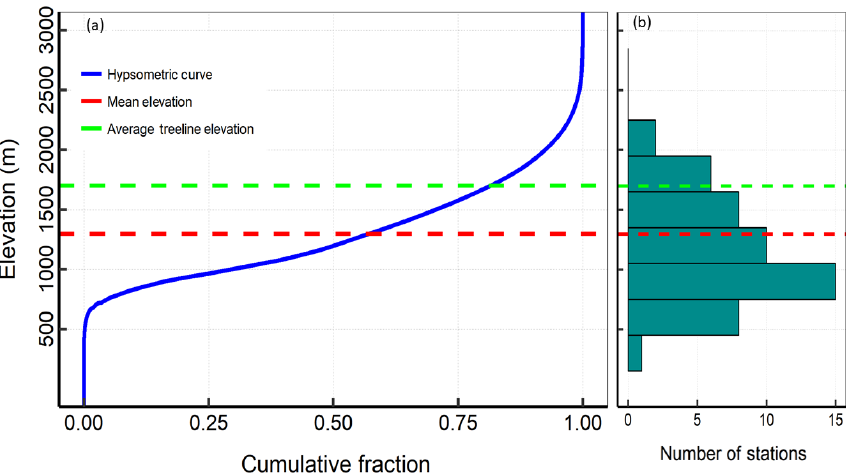
Figure 1. (a) Hypsometric curve showing the cumulative fraction of the elevation ranges in the Cariboo Mountains region. (b) The number of active weather stations at different elevations within the Cariboo Mountains